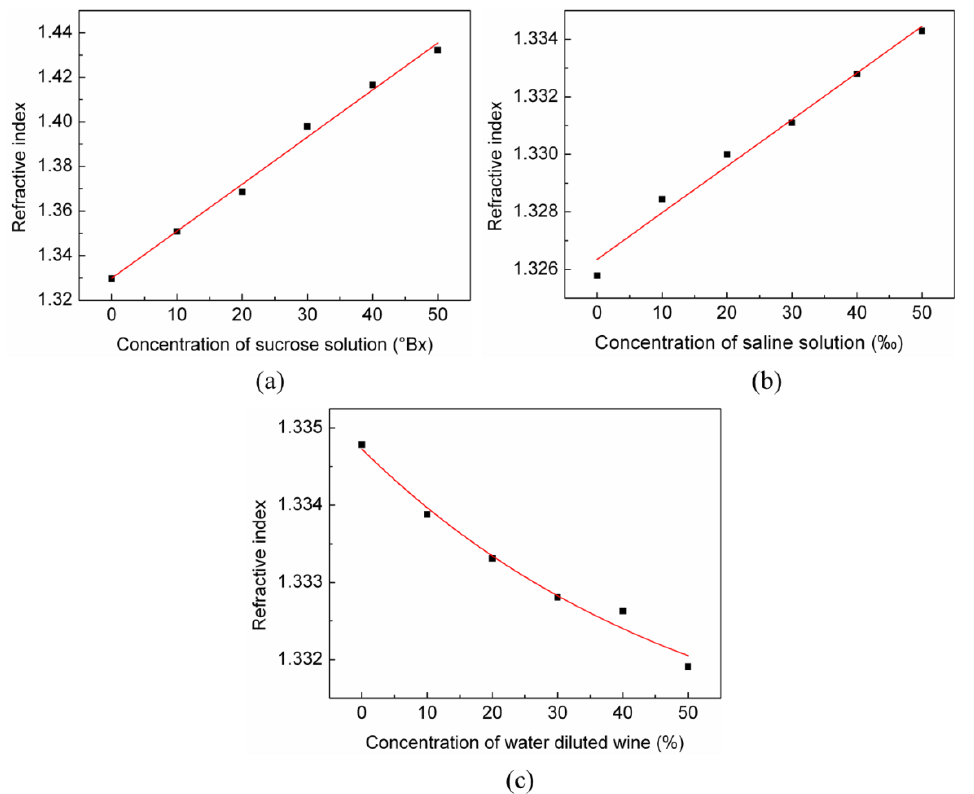
Figure 6. The measured refractive index for three di ff erent kinds of solutions. ( a ) Sucrose solutions with di ff erent degrees of Brix; ( b ) saline solutions with di ff erent permilles; and ( c ) water-diluted wines with di ff erent dilution rates.